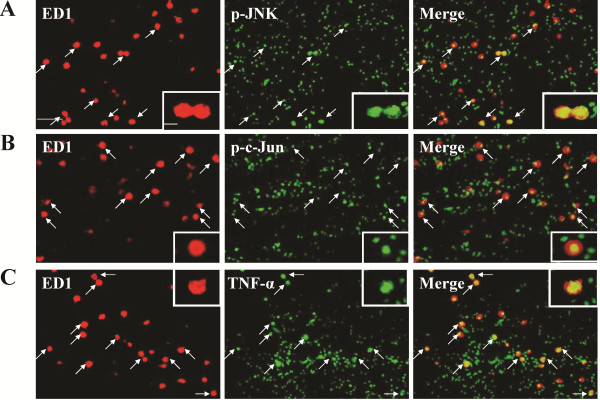
Activated microglia expressed p-JNK, p-c-Jun and TNF-α. Immunofluorescence of the ipsilateral white matter in the lipopolysaccharide (LPS) + hypoxic-ischemic (HI) group 24 h post-insult showed that ED1-positive activated microglia expressed phospho-c-Jun N-terminal kinases (p-JNK) (A) and TNF-α (C), and had nuclear translocation of p-c-Jun (B). Scale bar = 25 μm. Inset scale bar = 5 μm.